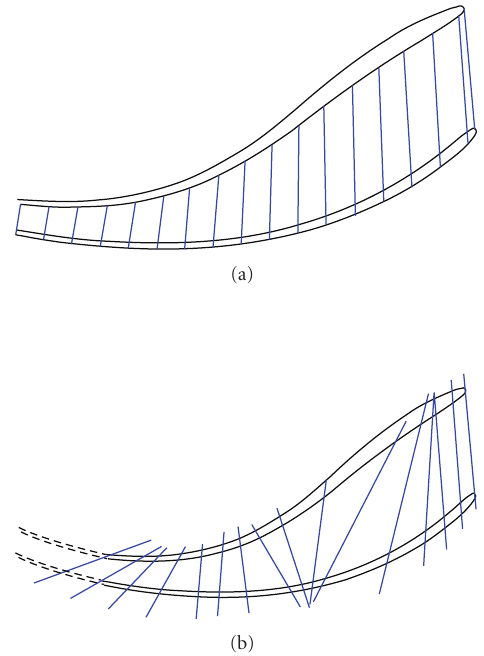
Figure 4: Examples of blade definition by means of straight-line